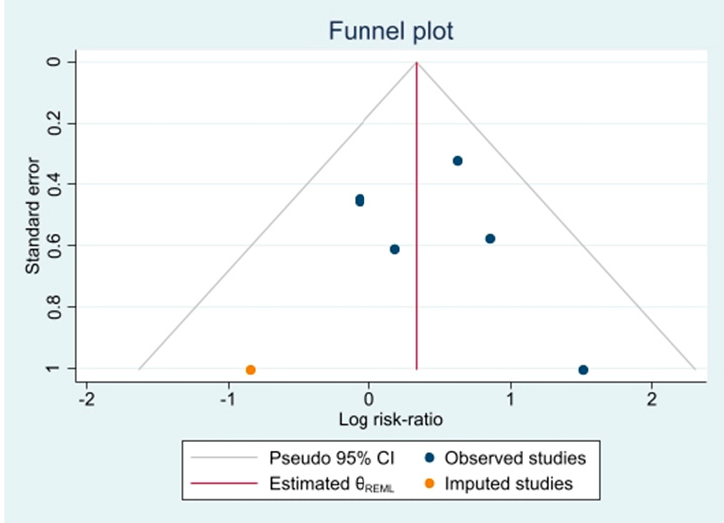
Figure 5. Funnel plot of publication bias